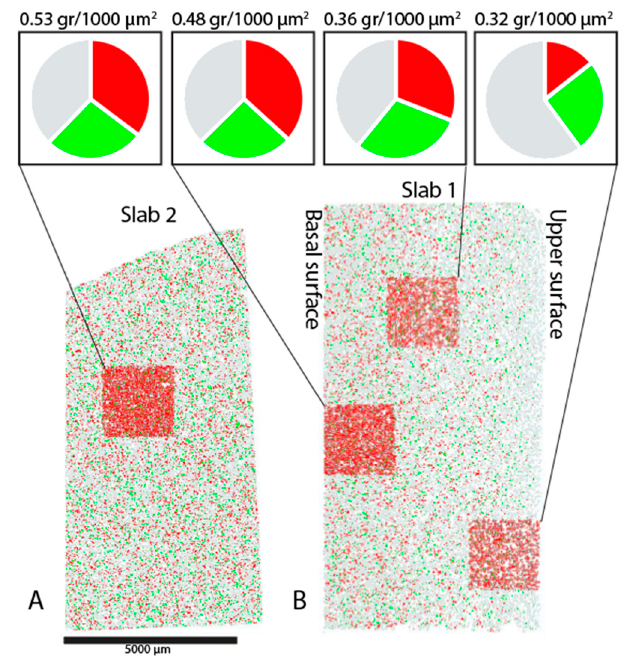
Figure 4. False-color grain maps of: ( A ) a portion of the slab 2 basal surface of a HMC epoxy grain mount, and ( B ) the entire slab 1 vertical cross-sectional surface of a HMC epoxy grain mount. Particle abundance per unit area and the relative abundance of heavy (red), intermediate (green) and light (grey) are depicted in the pie charts above for each red-shaded area. Three sections were analyzed on the vertical slabs and they display variations in particle abundance with depth through the slab.